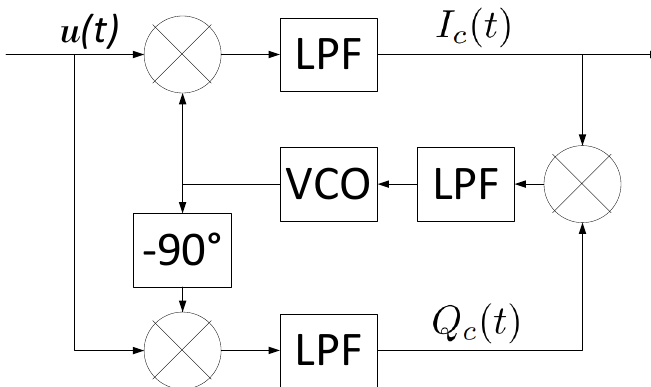
Figure 6. Classical Costas Loop for demodulating a dual sideband, suppressed carrier (DSB-SC) signal u ( t )